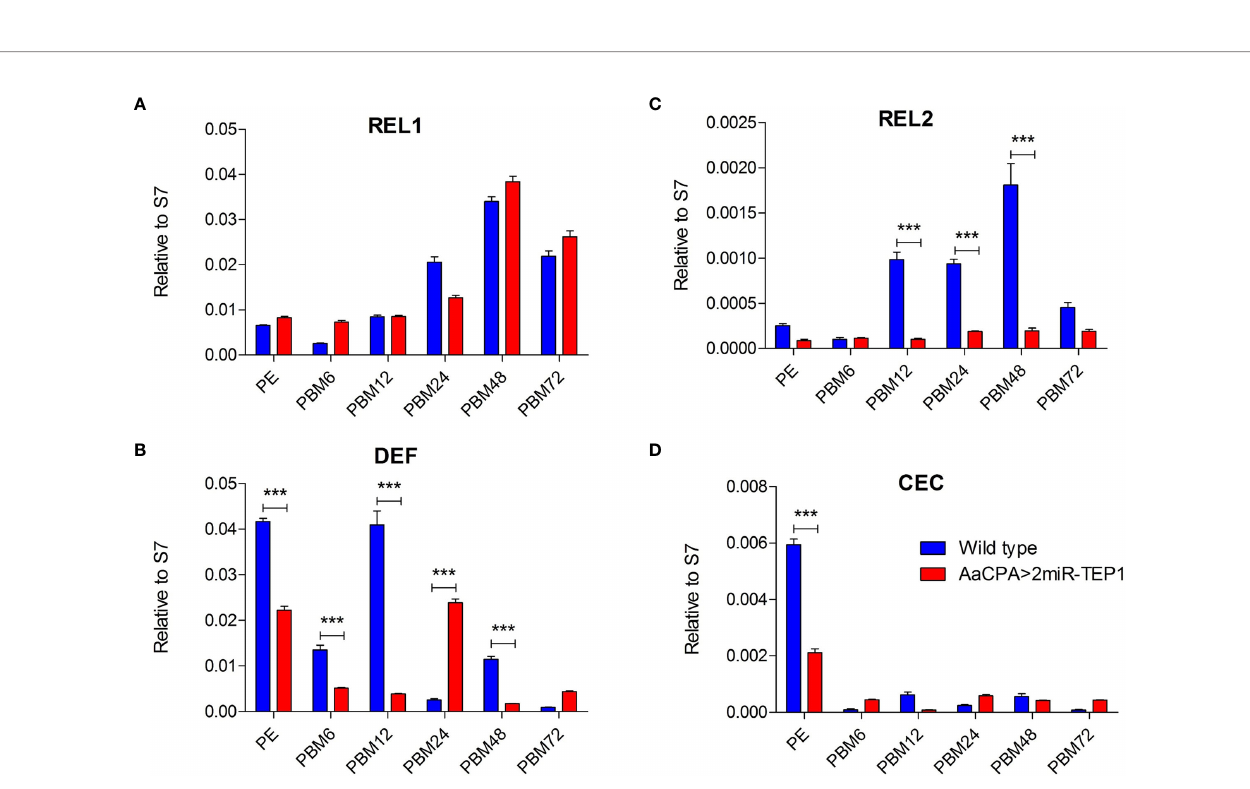
FIGURE 5 | Role of Defensins and Cecropins in Thioester-Containing Protein 1 (TEP1) Transgenic Mosquitoes after Blood Meals. (A – D) The whole bodies of female wild type or transgenic mosquitoes (AaCPA>2miR-TEP1) were collected 6, 12, 24, 48, and 72 hours after a normal blood meal. Total RNA was extracted and quanti fi ed, followed by cDNA synthesis and subjected to quantitative real-time PCR analysis with a speci fi c primer for Rel1 (A) , Rel2 (B) , defensins (C) , and cecropins (D) . At least three biological cohorts from each time point were used for analysis. Ribosomal protein S7 was used for normalization of relative target gene mRNA expression. PE means